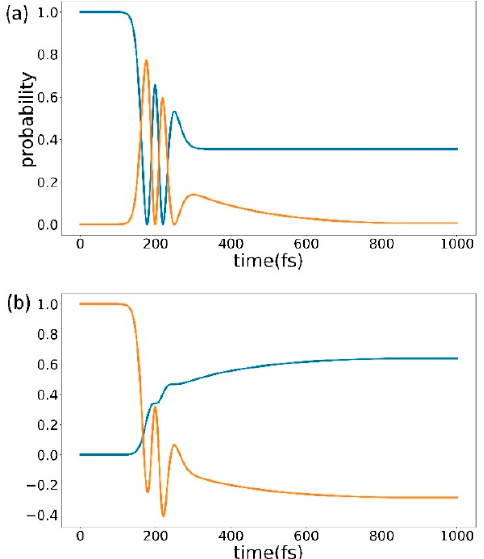
Figure 3. ( a ) Blue and orange lines represent probabilities of electrons staying at ground state 0 S and singlet state 1 S, respectively, The Rabi oscillation with decaying to triplet state. The final probability of 0 S steady at 0.4; ( b ) Probabilities of electrons decaying to 1 T and the dynamic of spin state are presented in blue and orange lines.